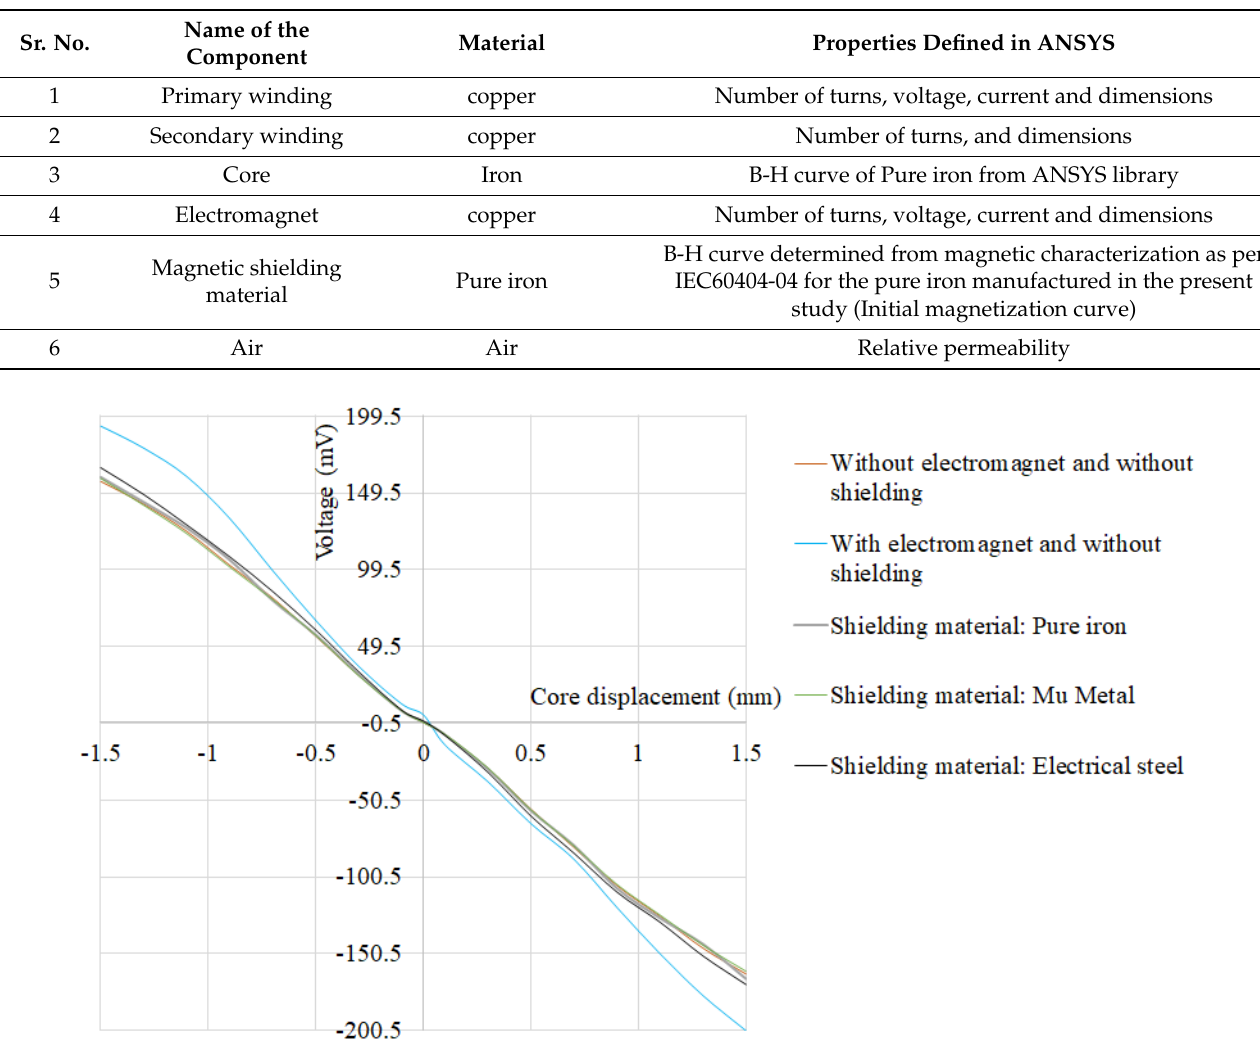
Table 10. Properties defined in ANSYS.